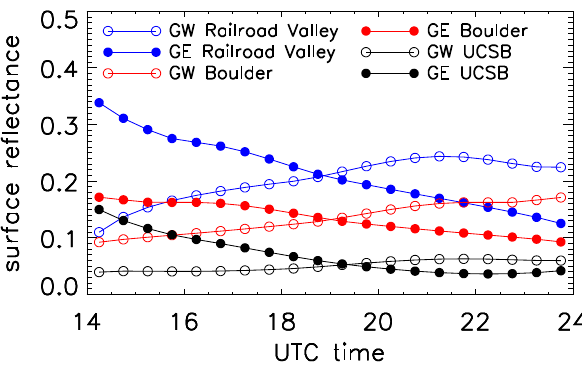
Fig. 9. Diurnal variation of surface reflectance at the three AERONET sites on 19 June 2008, where GW represents GOES- West and GE represents